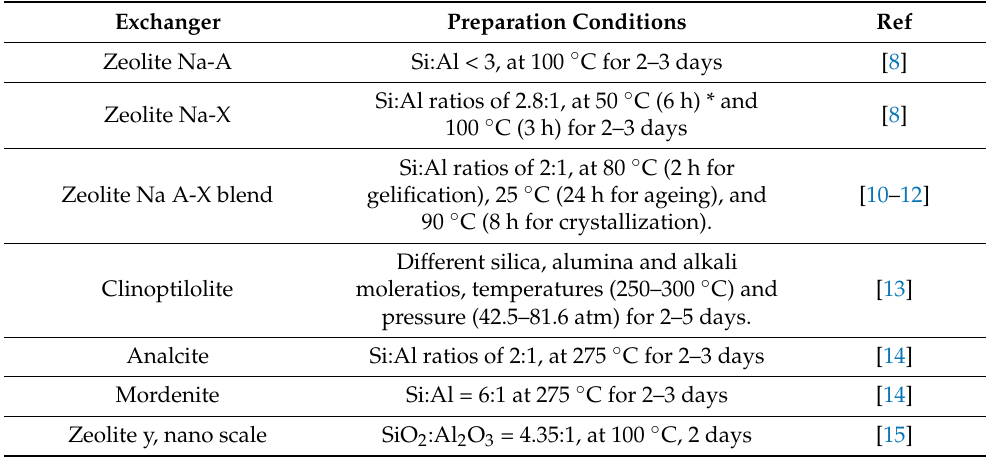
Table 1. Examples zeolites hydrothermal preparation conditions (Reprinted with permission from [7]). Exchanger Preparation